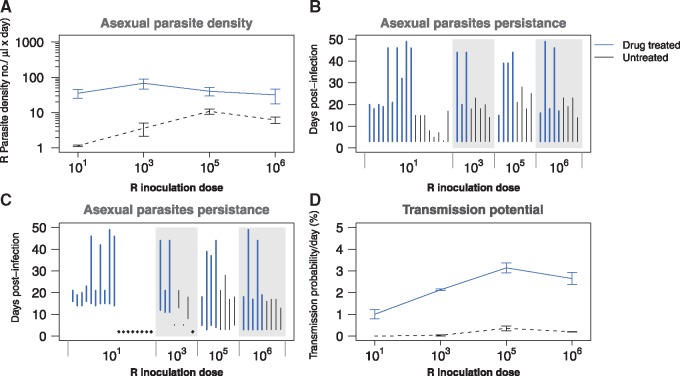
Competitive release—comparative performance of clone R in competition in the presence (blue lines) and absence (black lines) of drug treatment. (A) Geometric mean asexual parasite density of clone R at different initial parasite dosages. (B) Duration of infection of resistant parasites (time to last detection by qPCR) for the different R inoculum sizes. Each line represents the duration of one single infection. (C) Duration of infectious period (from first to last detection of gametocytes by qPCR) for the different R inoculum sizes. Diamonds represent infections that did not produce any gametocytes. (D) Mean transmission probability per day at different initial parasite dosages based on a gametocyte density-infectivity function [65]. Data in (A) and (D) are means (±SEM) from the post-treatment infection period (Days 10–49 PI) of up to five mice (R inoculum sizes 106, 105, 103) or up to 10 mice (inoculum size 101; Table 1)